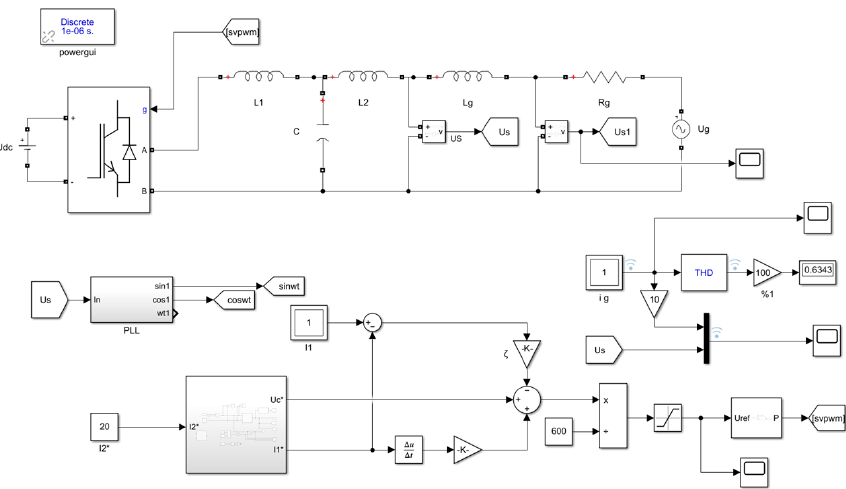
Figure 7. The overall simulation model of single-phase weak grid LCL grid-connected inverter.